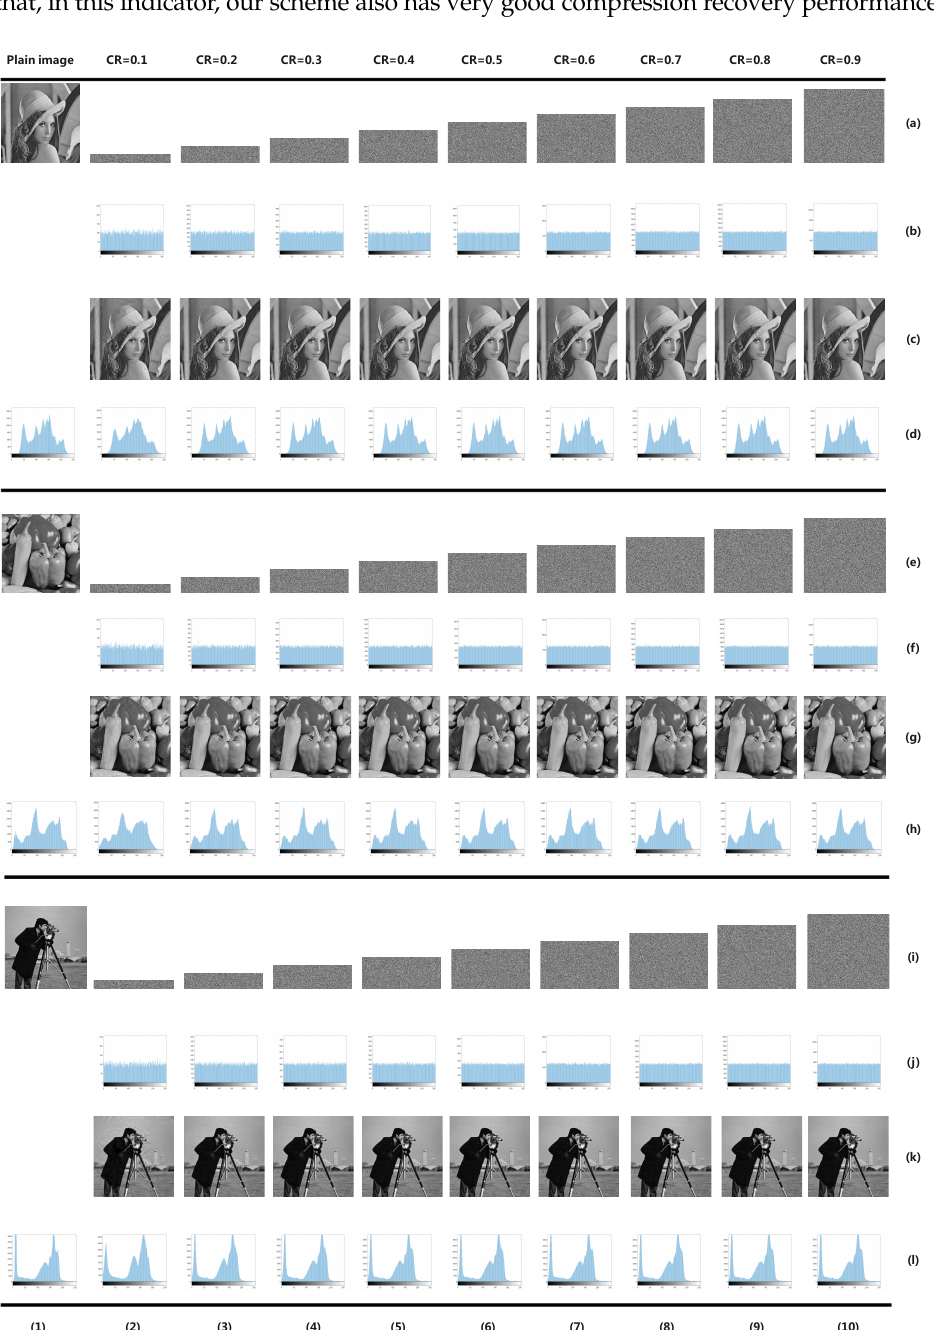
Figure 3. Encryption simulation. Rows ( a – d ) are the simulation results of image ’Lena’, Rows ( e – h ) are the simulation results of image ’Pepper’ and Rows ( i – l ) are the simulation results of image ’Cameraman’. Column ( 1 ) are plain images. Columns ( 2 – 10 ) are the simulation results of CR = 0.1, · · · , CR = 0.9,